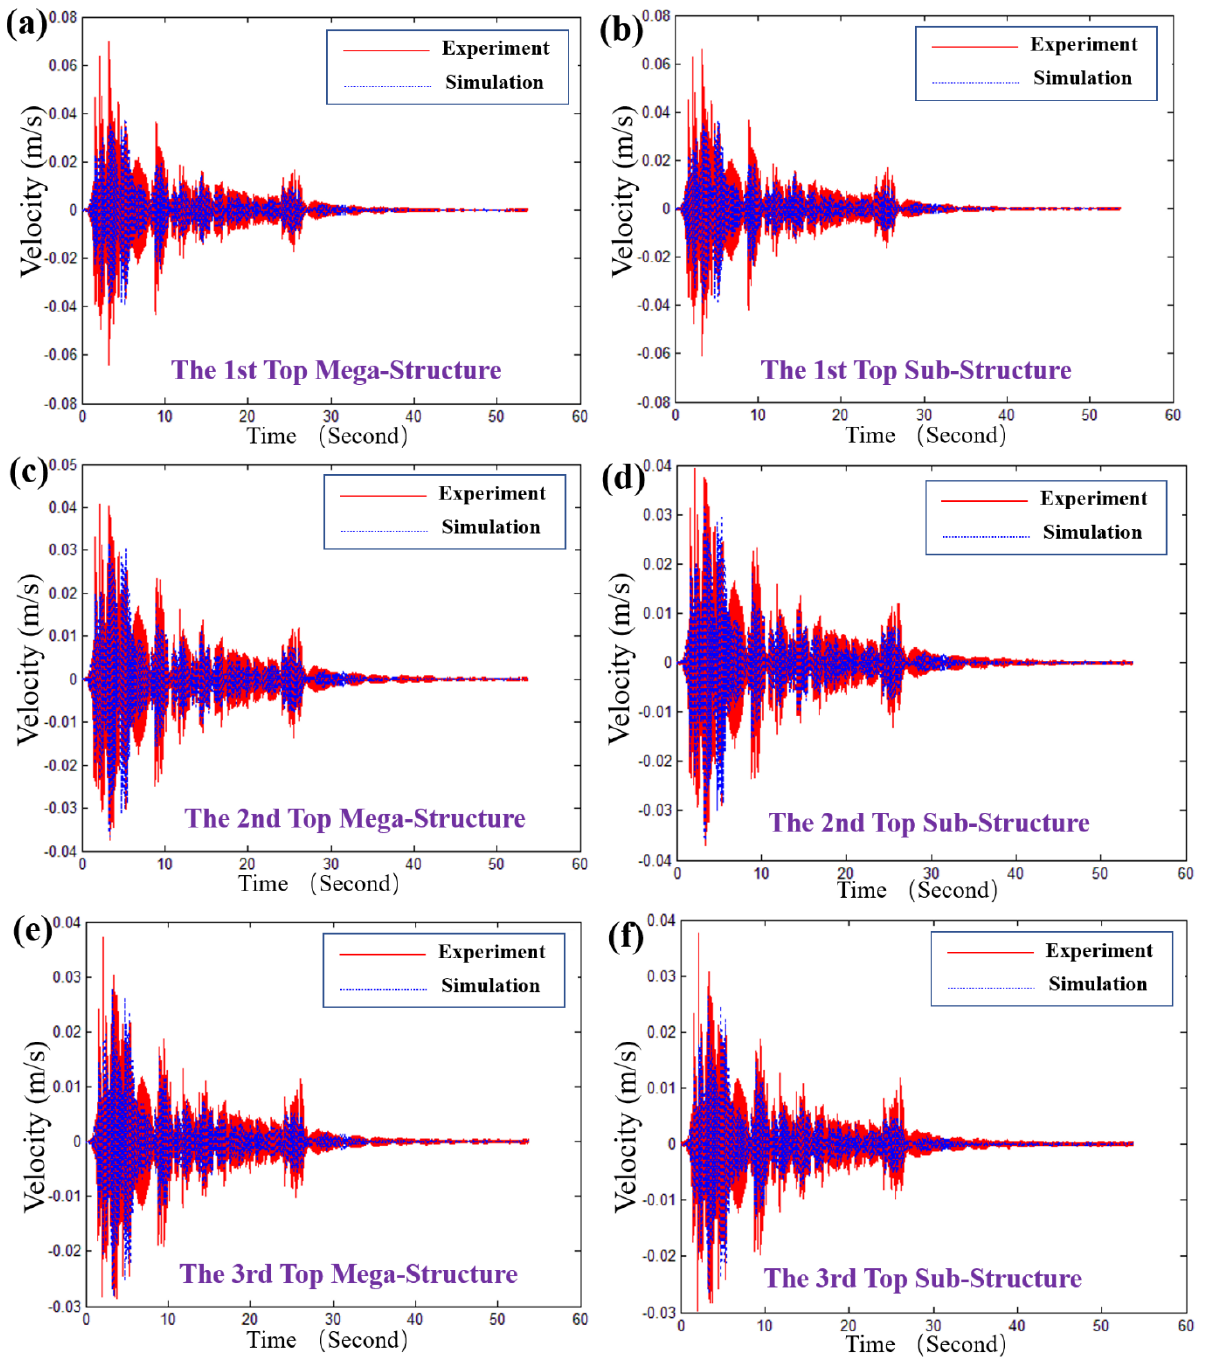
Figure 6. The response of the typical structural unit of MSCSS0001 to the El Centro wave: ( a ) the top of the first megaframe; ( b ) the top of the first substructure; ( c ) the top of the second megaframe; ( d ) the top of the second substructure; ( e ) the top of the third megaframe; ( f ) the top of the third substructure.